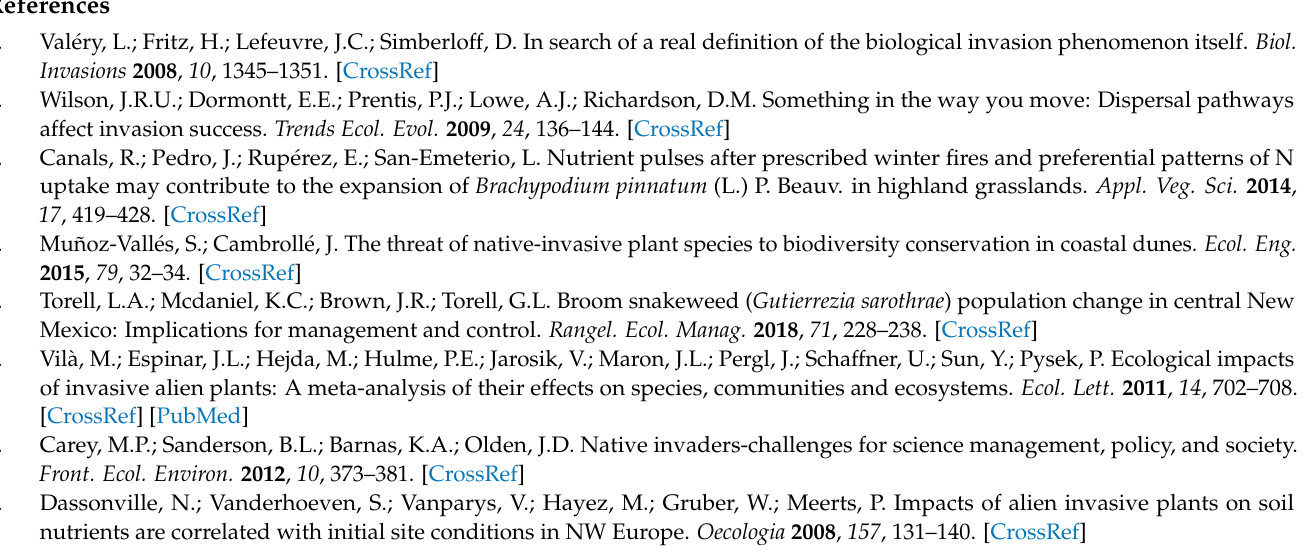
Table S1: Coefficient (r) for the correlations between the relative abundances of taxonomic groups and soil physicochemical